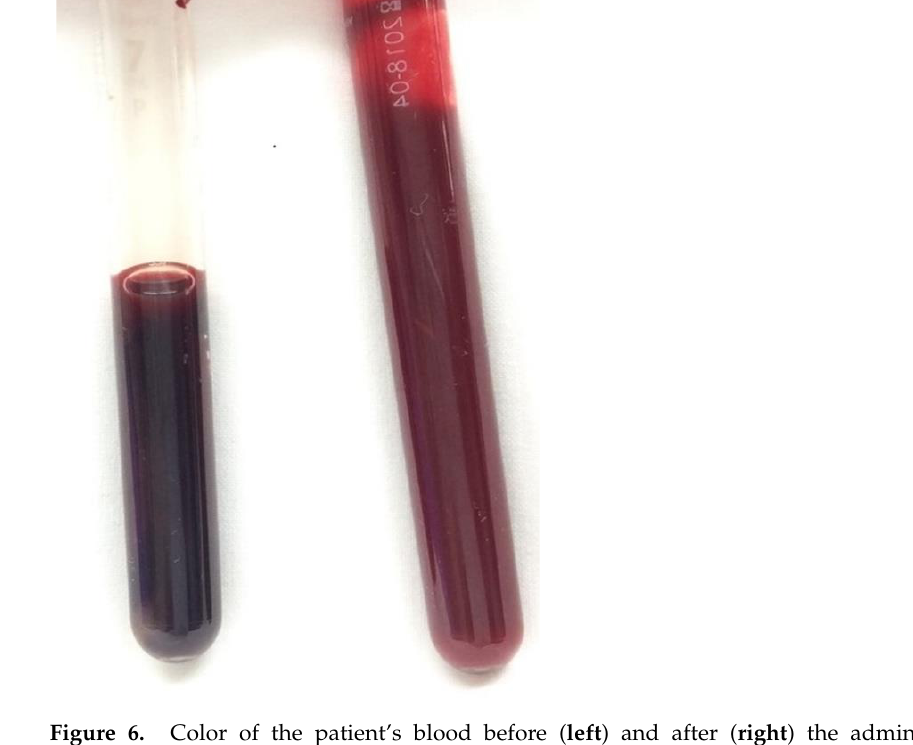
Figure 6. Color of the patient’s blood before ( left ) and after ( right ) the administration of methylene blue.